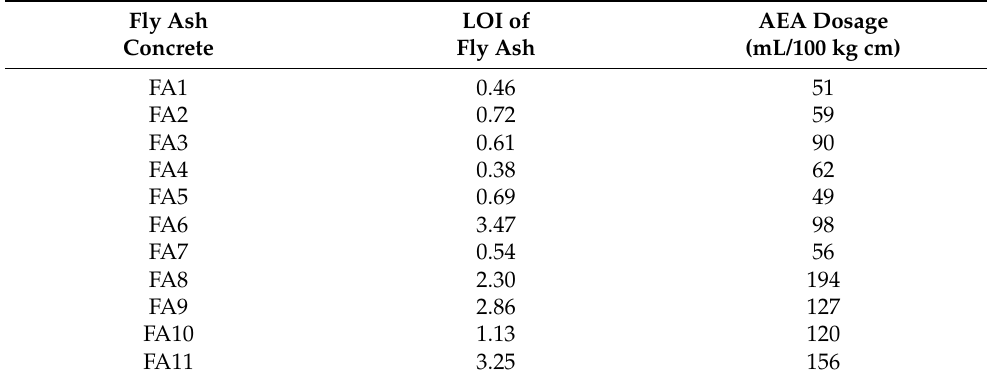
Table 6. The needed AEA dosage to obtain an initial air content of 6 ±